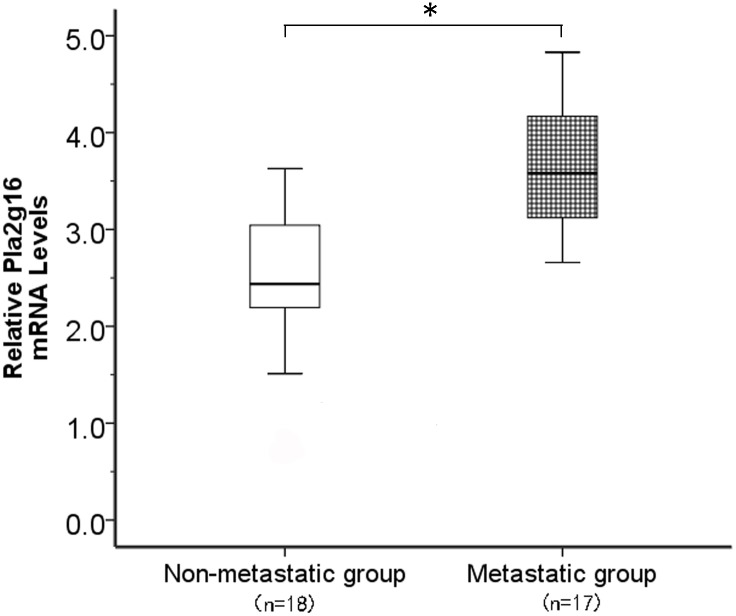
PLA2G16 expression in osteosarcoma tumors with or without metastasisThe PLA2G16 mRNA levels were determined by real-time quantitative PCR. *denote p values P<0.05.